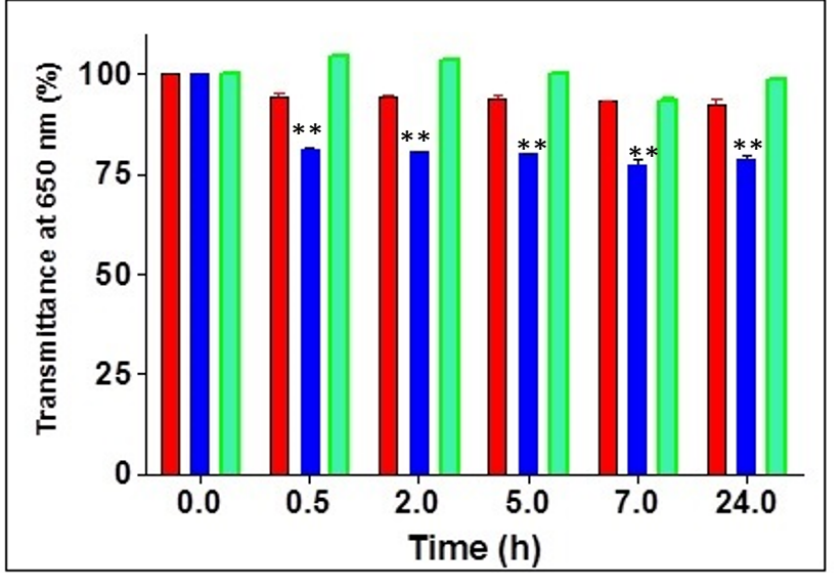
Figure 10. Mucoadhesive effects in SNF of AlgOX (red bars) and AlgOX-DA imine conjugate (blue bars). HEC (green bars) was used as positive control; ** p ≤ 0.001.